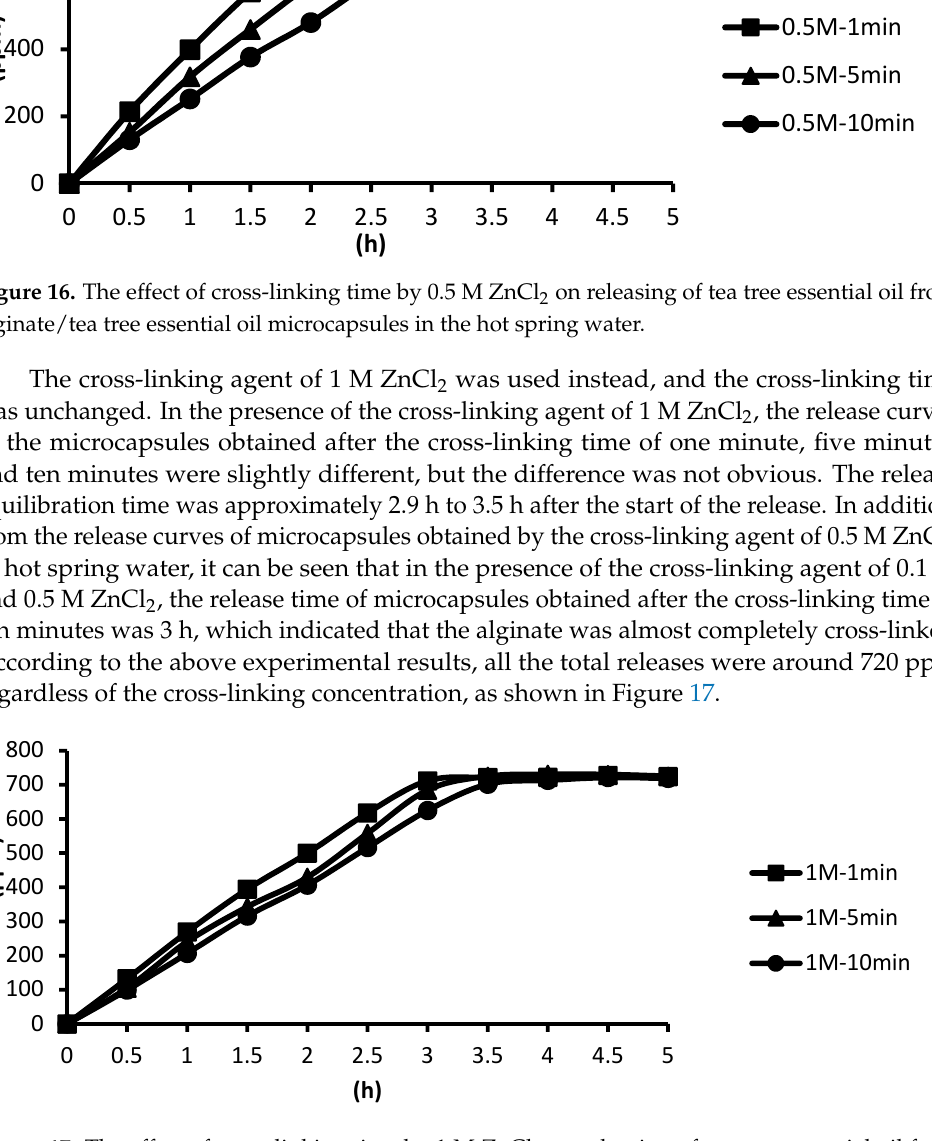
Figure 15. The effect of cross-linking time by 0.1 M ZnCl 2 on releasing of tea tree essential oil from